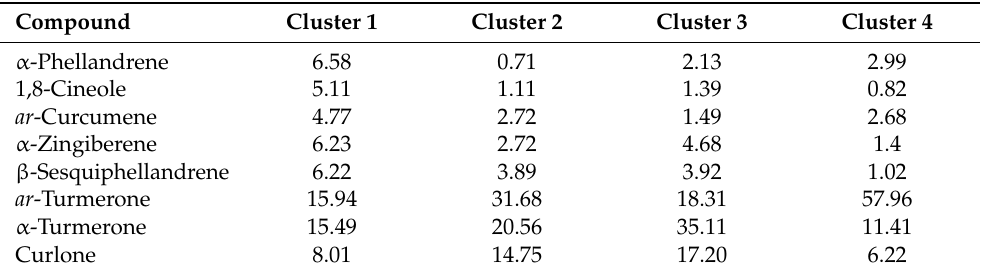
Table 6. Concentration (%) of centroids used in the cluster analysis of Curcuma longa rhizome oils.